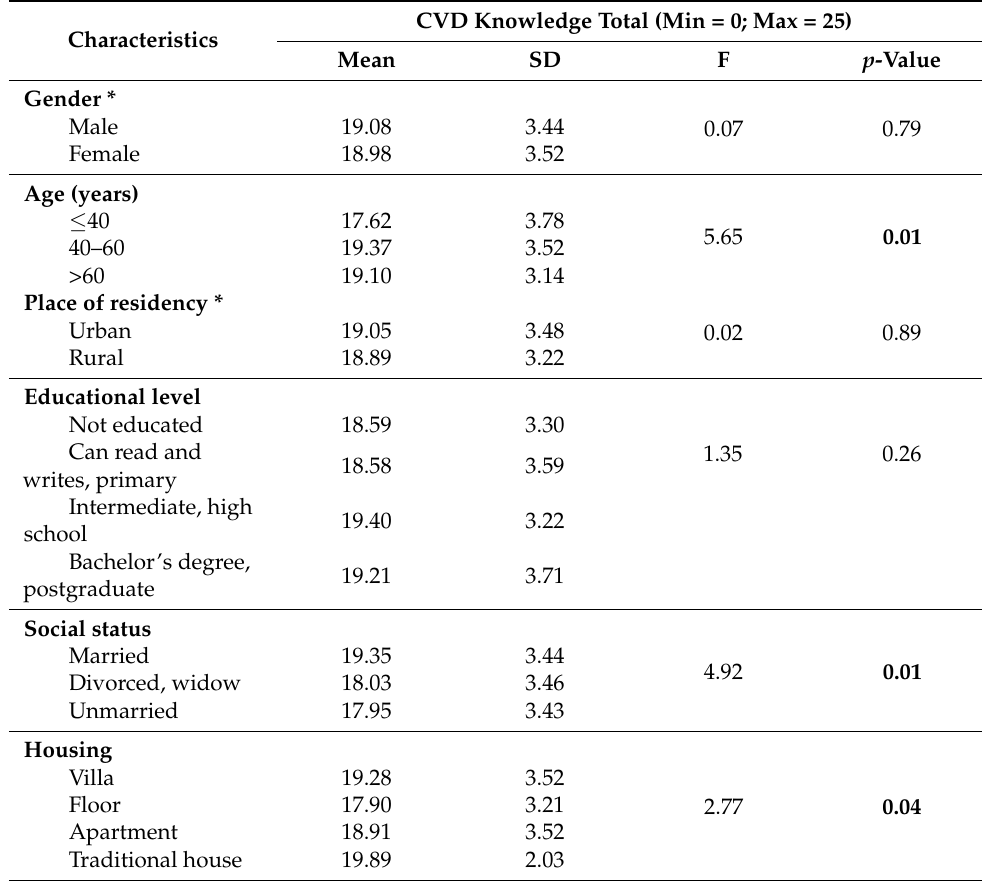
Table 4. Sample population characteristics with analysis of variance tests for knowledge